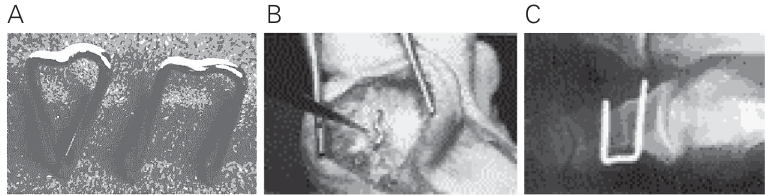
Figure 9. A , Orthopedic staples. B , Staples placed in a human foot. C , X-ray of a human foot. Taken from Ref. 30